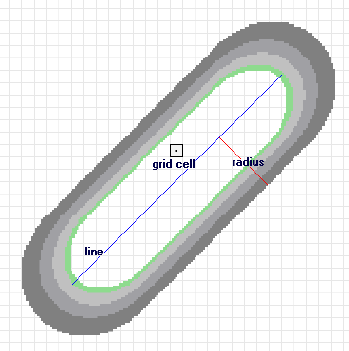
Figure 2. Line kernel function segmenting and fitting